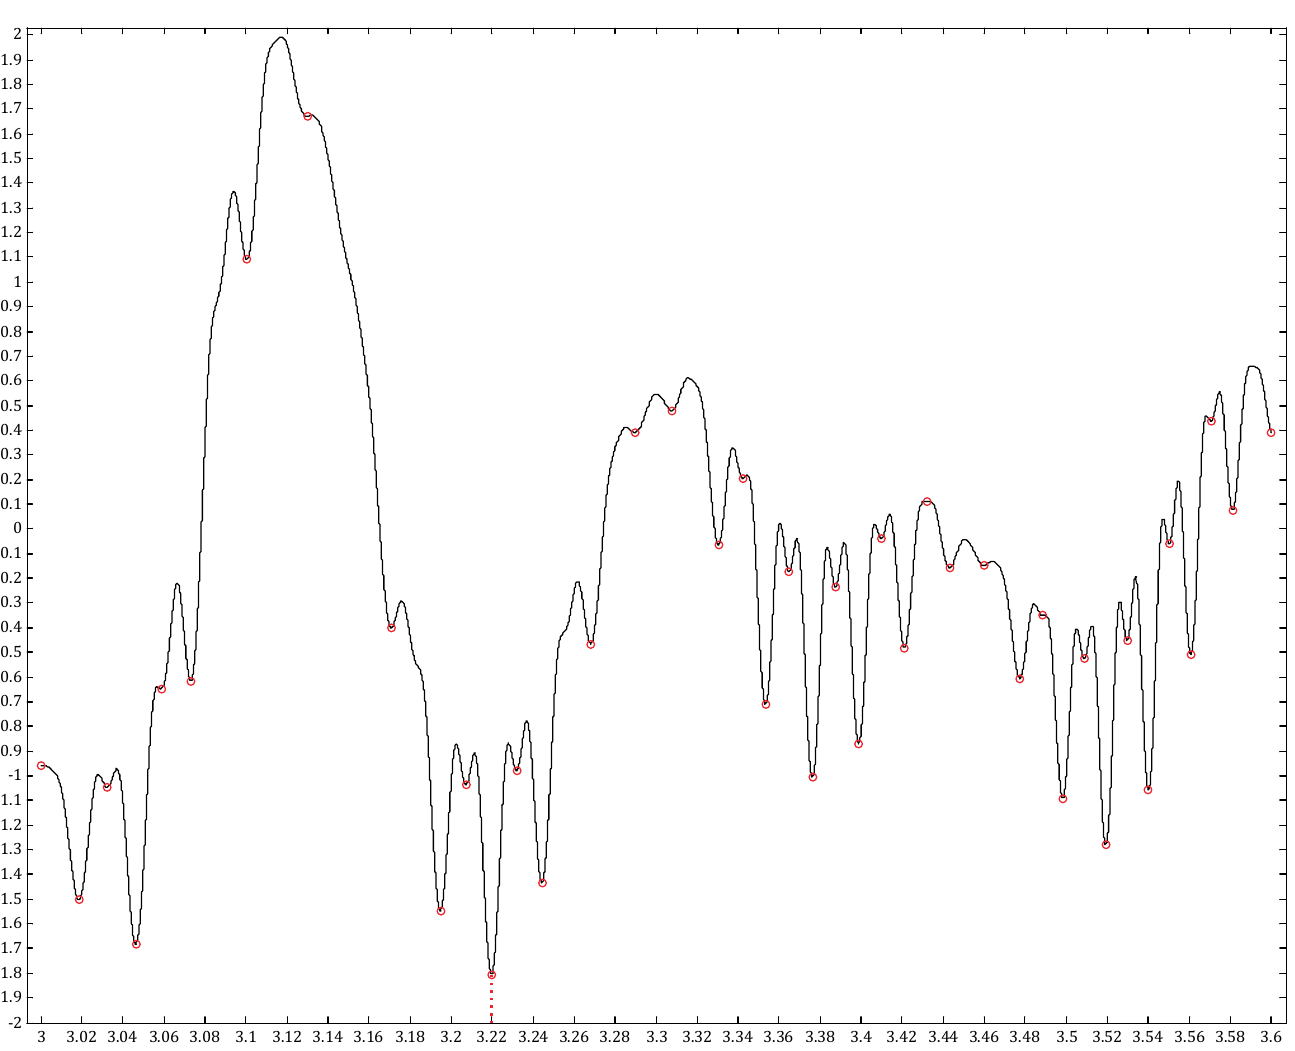
Fig. 8. The 41 local minima, including both the local boundary minima and the global minimum (marked by the dotted line downward) of function (45) on interval [3;